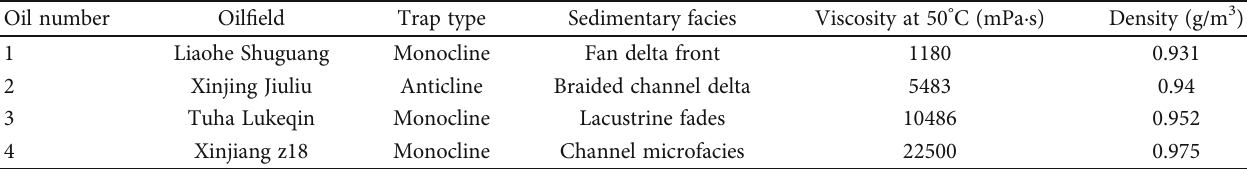
Table 1: Oil sample and reservoir information.